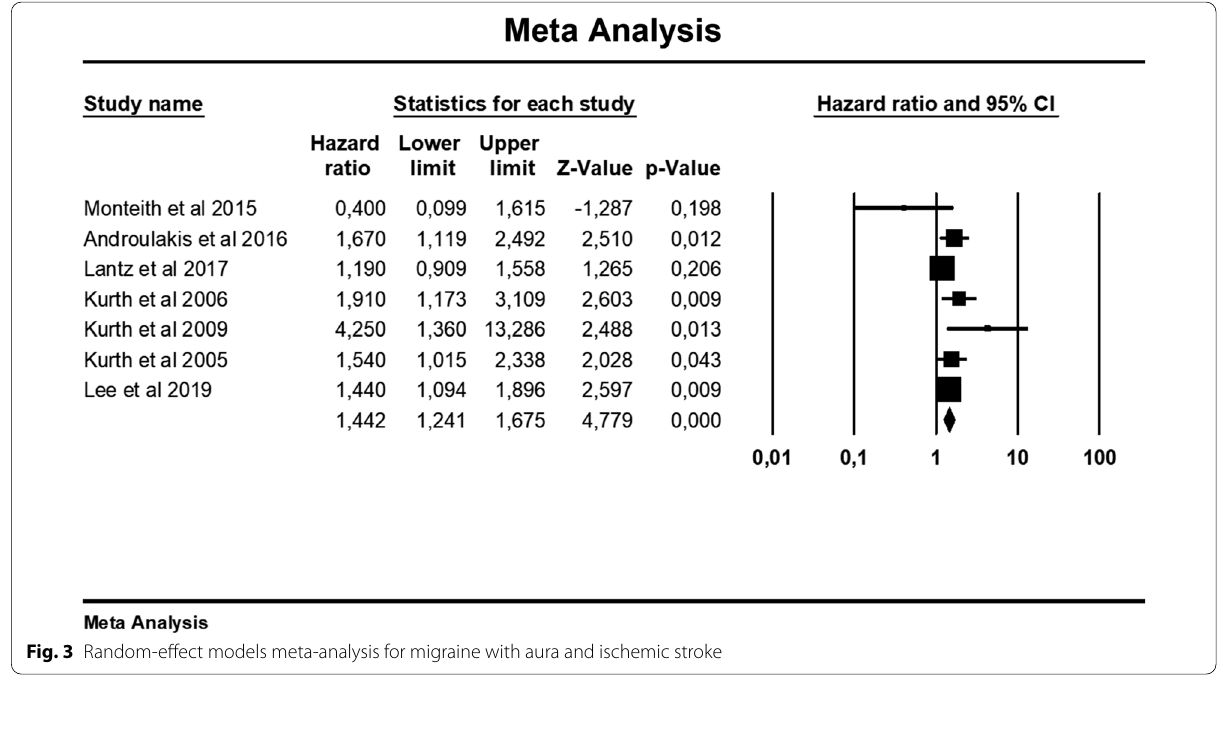
Fig. 3 Random-effect models meta-analysis for migraine with aura and ischemic stroke